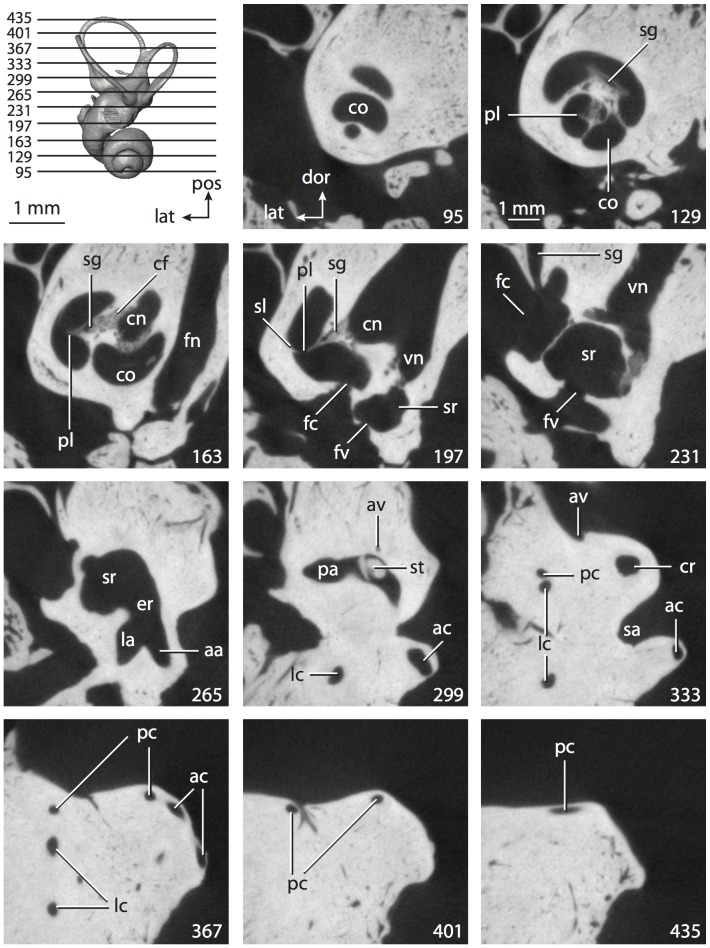
CT slices through ear region ofEumetopias jubatus.Abbreviations listed at the end of the Materials and Methods section.